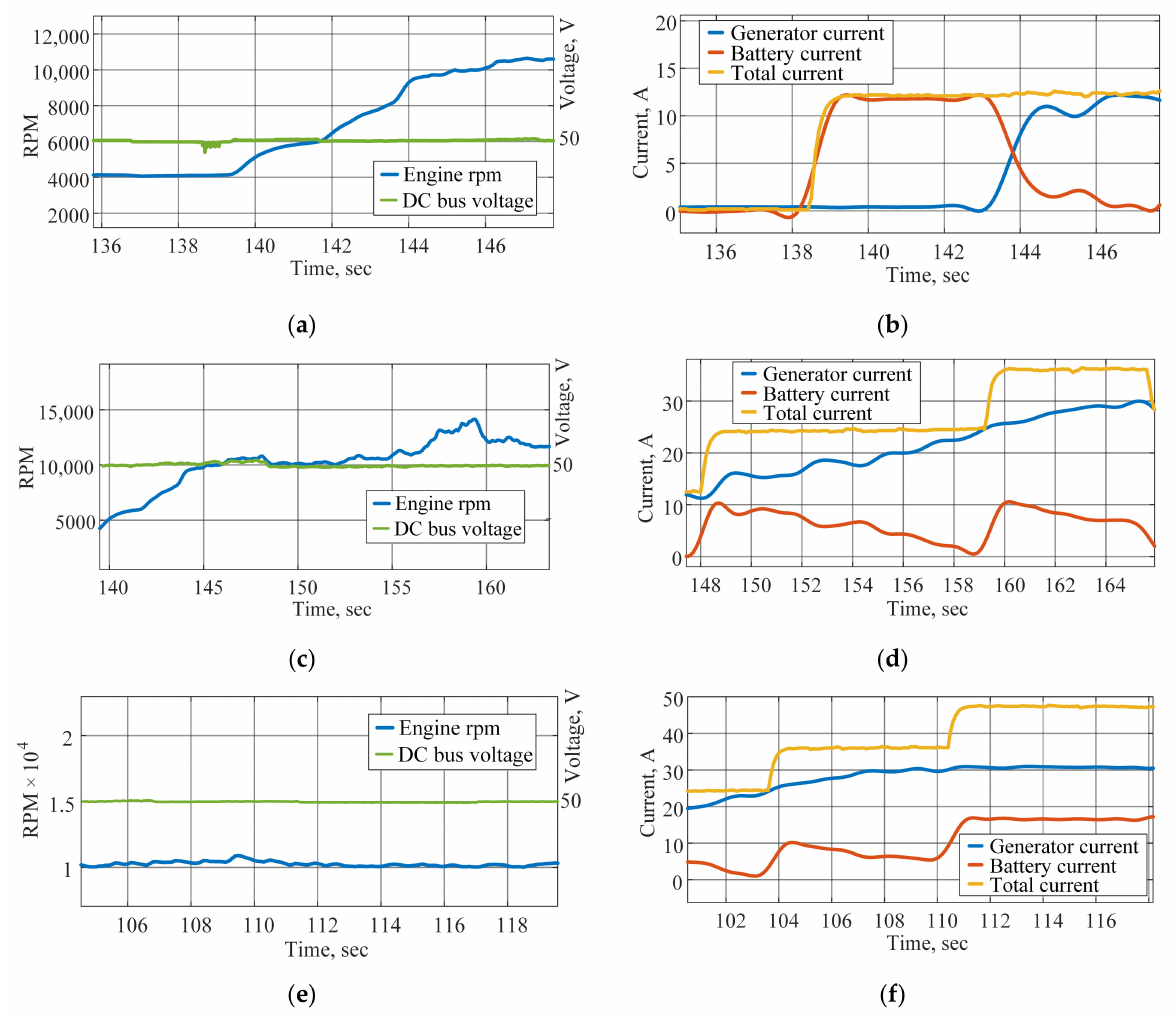
Figure 18. Low load responses ( a ) RPM and DC bus voltage, ( b ) DC bus currents; Medium and high load responses ( c ) RPM and DC bus voltage, ( d ) DC bus currents; High load (1.33 Ω ) and peak load (1 Ω ) response ( e ) RPM and DC bus voltage, ( f ) DC bus